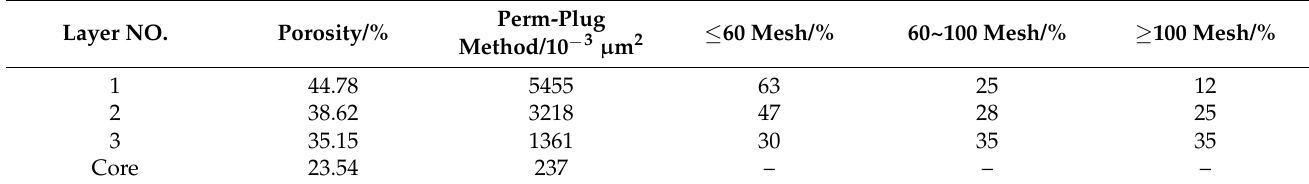
Table 1. Quartz sand mesh ratio of reservoirs with different